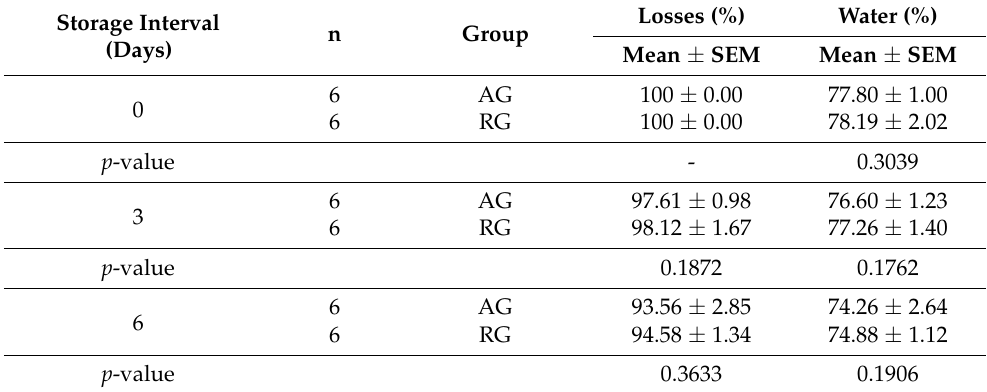
Table 4. Comparative evaluation of losses and water content in European catfish refrigerated fillets throughout different storage